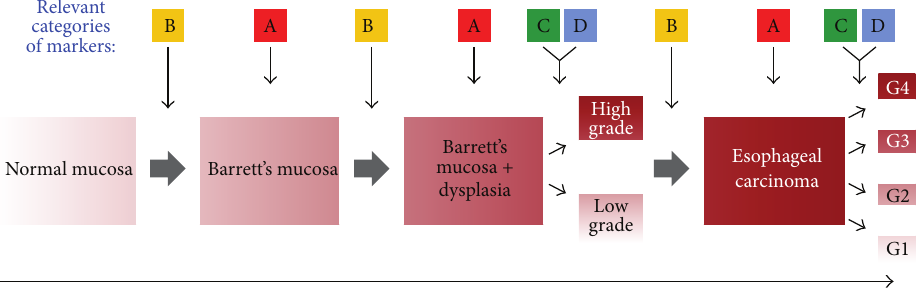
Figure 1: GERD-associated progression for Barrett’s esophagus (BE) to esophageal adenocarcinoma (EAC). A–D refer to biomarkers which could be most relevant at the indicated stages of the disease progression (according to Table 1). Therefore A, B, C, and D stand for diagnostic, progressive, predictive, and prognostic biomarkers, respectively.